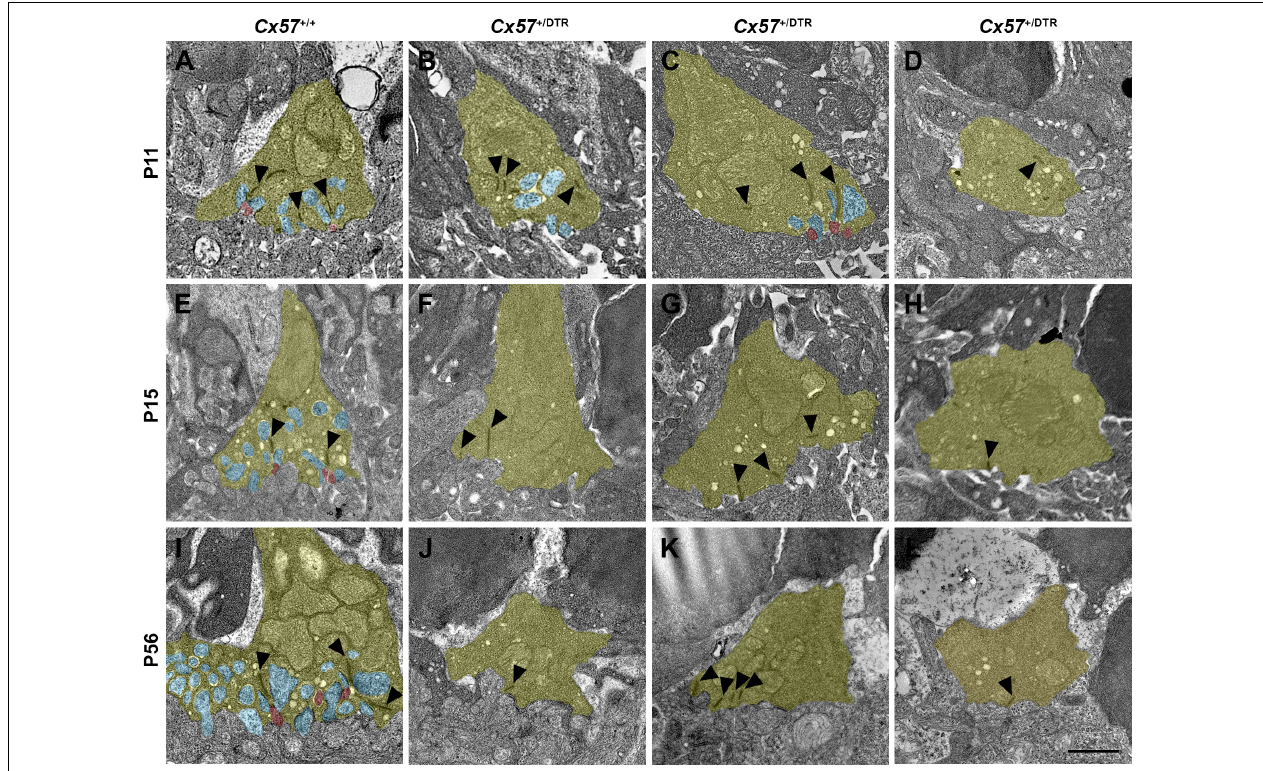
FIGURE 7 | Loss of ON bipolar cell invaginations in cone terminals. (A–L) Electron microscopic analysis of individual cone terminals from Cx57 + / + and Cx57 + / DTR mice at different ages (P11, P15, and P56). Cone terminals (yellow) in wild-type mice contained triads composed of horizontal cell dendrites (blue) and ON bipolar cell dendrites (red) as early as P11 (A,E,I) . In horizontal cell-ablated mice, some cone terminals with horizontal cell invaginations were found at P11 (B) . However, triads were rarely observed (C) and most cone pedicles contained no invaginations (D) . At P15 and P56, cone terminals were generally lacking any invaginations